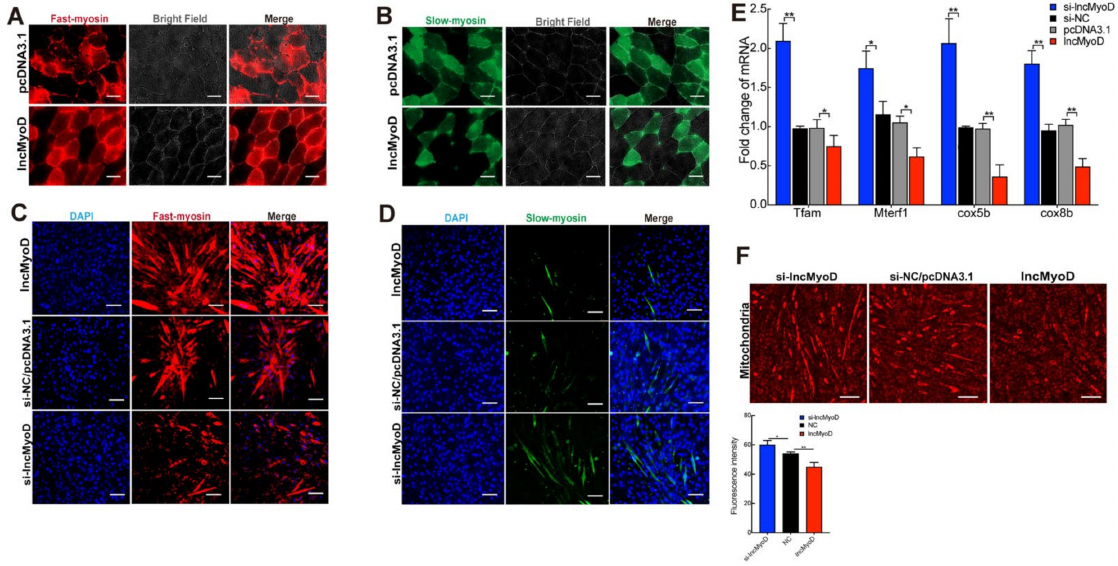
Figure 3. Increased expression of lncMyoD affects skeletal myofiber composition in vitro . pcDNA3.1-lncmyod and pcDNA3.1 were injected into mice via intraperitoneal injection of 4-wk-old mice for 28 d. ( A , B ) Immunofluorescent staining results demonstrated that lncMyoD significantly promoted fast-myosin fibers and suppress slow-myosin fibers within a cross-section of the gas, and qRT-PCR analysis the expression level of gene-related fast- and slow-twitch fibers. Differentiated C2C12 myotubes were transfected with lncMyoD (pcDNA3.1-lncMyoD), pcDNA3.1, si-lncMyoD, and si-NC for 8 d, and immunofluorescence was used to analyze myosin-fast–positive ( C ) myosin-slow–positive ( D ). ( E ) The expression levels of gene-related mitochondrial biogenesis and mitochondrial OXPHOS were measured by qRT-PCR. ( F ) Immunofluorescence staining using mouse anti-mitochondria antibody was performed in differentiated C2C12 myotubes. Scale bars, ( F ) 100 µ m and ( A , B , D , E ) 50 µ m. Data are means ± SD. p -values are obtained from independent-samples t -tests. * p < 0.05, ** p <